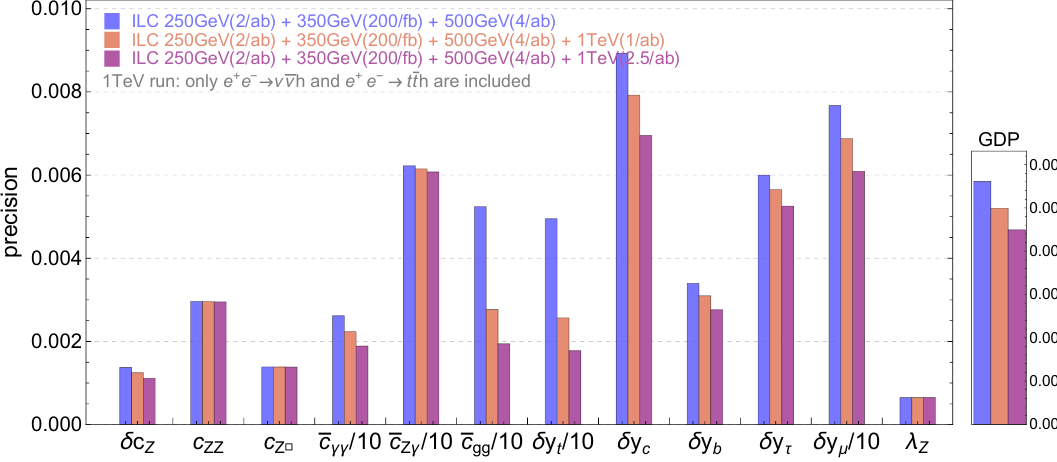
+ ) = ( 0 : 8 ; +0 : 3). For the (cid:0) ; e (cid:0) (cid:22) (cid:23)h and (cid:0) ! (cid:23) hZ and e + e (cid:0) WW are not ! !